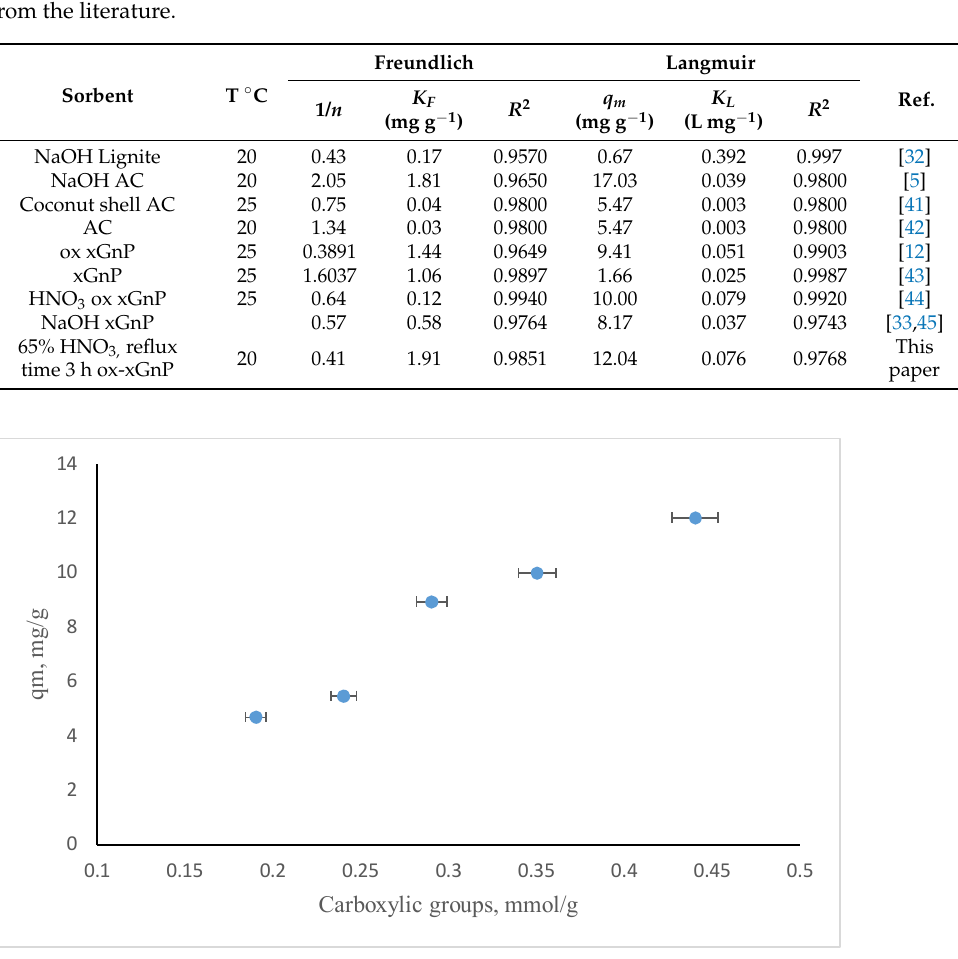
Table 5. A comparison of isotherm parameters of Freundlich and Langmuir models for NH 4+ ad- sorption from the literature.